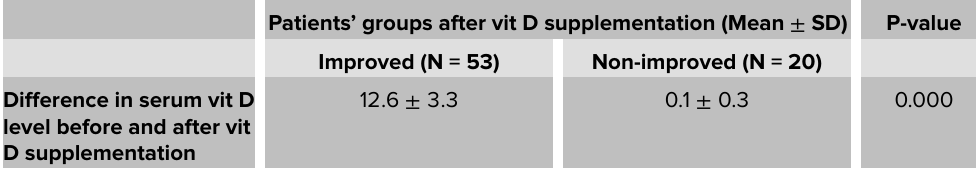
TABLE 2: The relationship between the difference in the serum level of vit D in improved and non-improved groups before and after vit D supplementation.